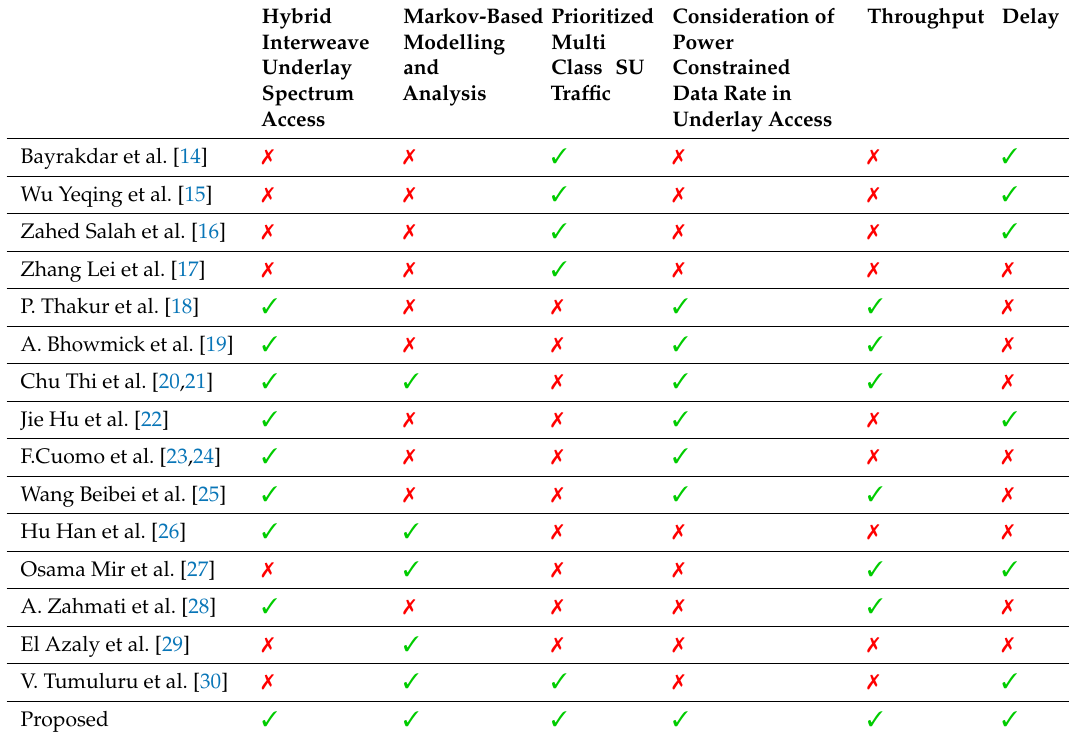
Table 1. Comparison of related work and proposed work in terms of Markov-based hybrid cognitive radio network (CRN) for multi-class secondary users (SU) under power constrained data